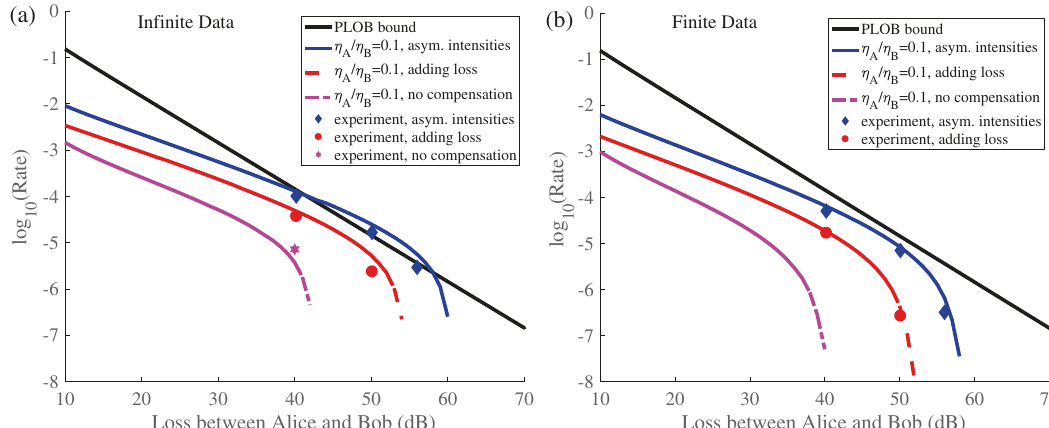
Fig. 3 Secret key rate (bit per pulse) in logarithmic scale as a function of the overall loss between Alice and Bob. The secret key rate is calculated for two cases, i.e., a the case where in fi nite data size is assumed and b the case where the data size is 3 × 10 10 and fi nite size effects are considered. The solid black line represents one representative of the repeaterless bound (PLOB bound). The blue solid curve is the simulated key rate with asymmetric signal intensities; the red dash curve is the simulated key rate with adding extra losses; the purple dash- dotted curve is the simulated key rate with no compensation. All the scattered points are the experimental secret key rates. The blue rhombi represent the case with asymmetric signal intensities; the red circles represent the case where extra 10 dB attenuation is added on Bob ’ s side; the purple hexagon is the key rate obtained when no compensation is applied. As observed, the strategy of applying asymmetric signal intensities always provides better key rates than the other two